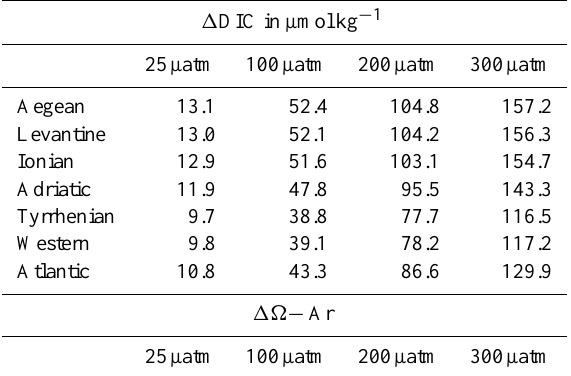
Table 4. Absolute associated changes in aqueous [CO 2 ] Table 5. Absolute associated changes in DIC concentration, pH and